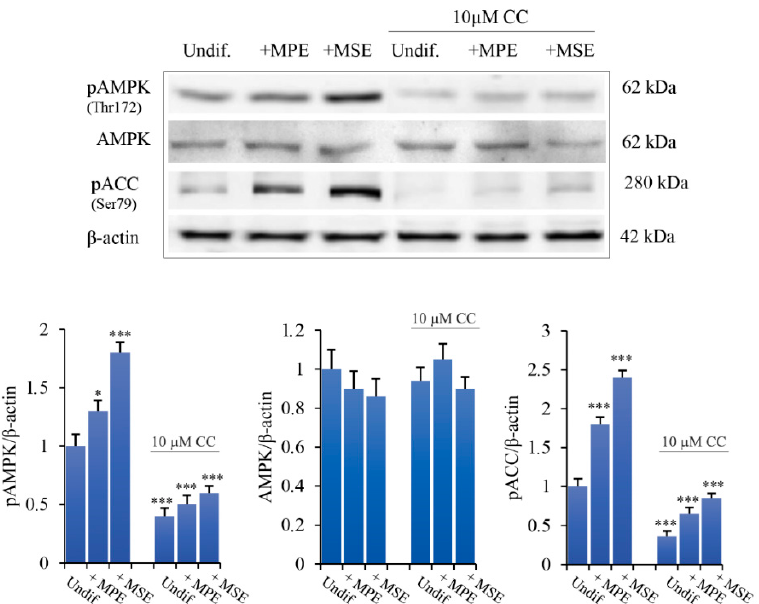
Figure 6. Compound C counteracts the effects of MPE and MSE on AMPK activation and ACC phosphorylation. Confluent 3T3-L1 cells were pre-treated for 4 h with 10 µ M AMPK inhibitor, compound C (CC), and for another 24 h in the presence or absence of 100 µ g/mL MPE or MSE. Cell extracts were then prepared and immunoblotted with antibodies to AMPK, phospho-AMPK, or phospho-ACC. Equal loading of proteins was verified by immunoblotting for β -actin and showed values were assigned in relation to undifferentiated 3T3-L1 cells (Undif). The bar graphs represent the mean of three independent experiments ± SD. * p < 0.05 and *** p < 0.001 with respect to the undifferentiated untreated 3T3-L1 cells.